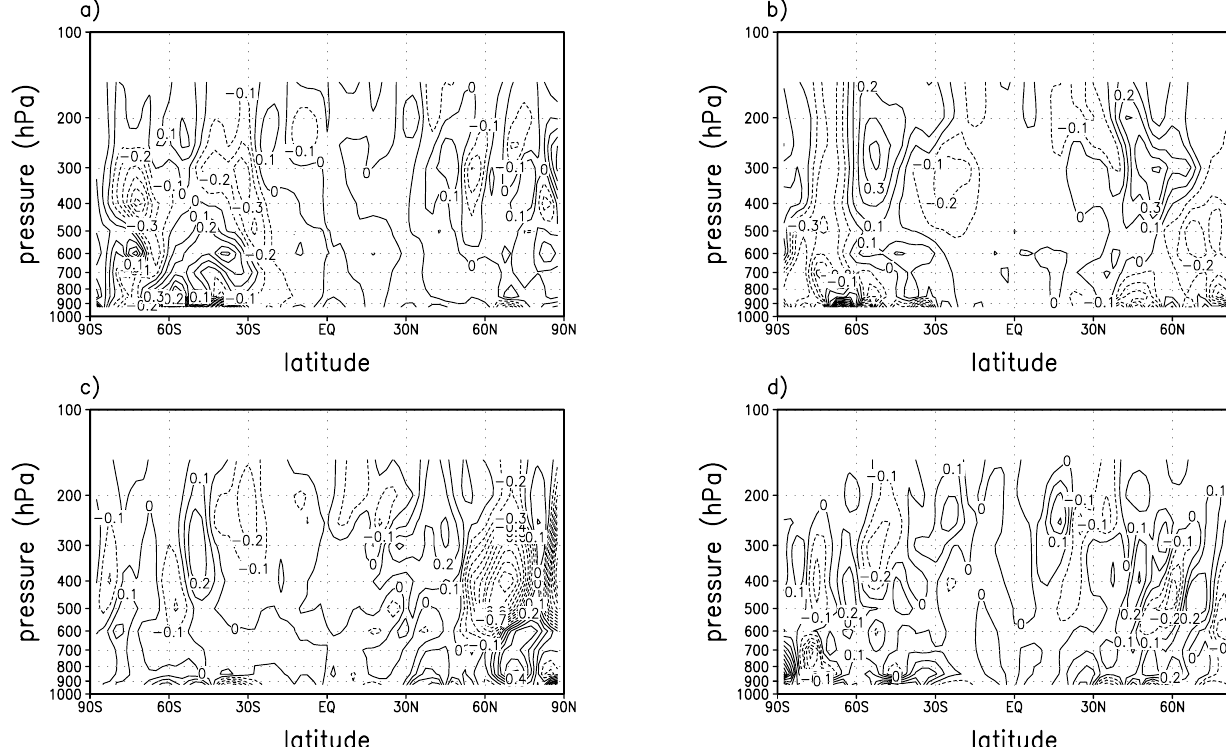
Fig. 5. Differences in PV transport for: (a) July 1997 minus 1995, (b) October 1997 minus 1995, (c) January 1998 minus 1996 and (d) April 1998 minus 1996. Units, 10 − 4 ms − 2